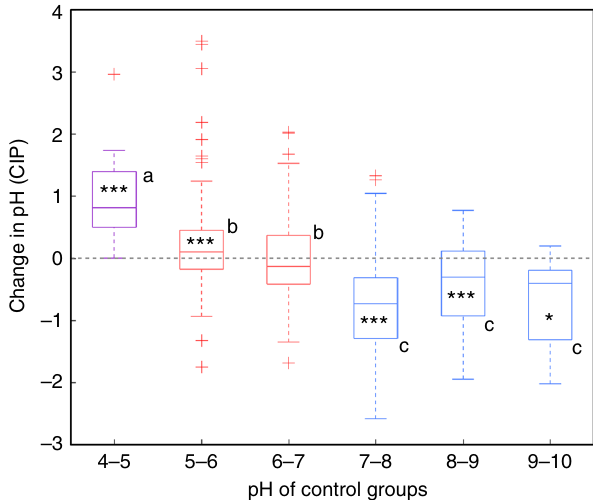
Fig. 3 Comparison of CIP across groups of different initial pH. In box- whisker plots, the central mark indicates the median, and the bottom and top edges of the box indicate the 25th and 75th percentiles, respectively. The maximum whisker lengths are speci fi ed as 1.5 times the interquartile range and outliers are marked using +. Independent sample t -tests with false discovery rate (FDR) correction were conducted to compare data of each group with 0. Symbols *, **, and *** indicate that the null hypothesis could be rejected at a signi fi cance level of 0.05, 0.01, and